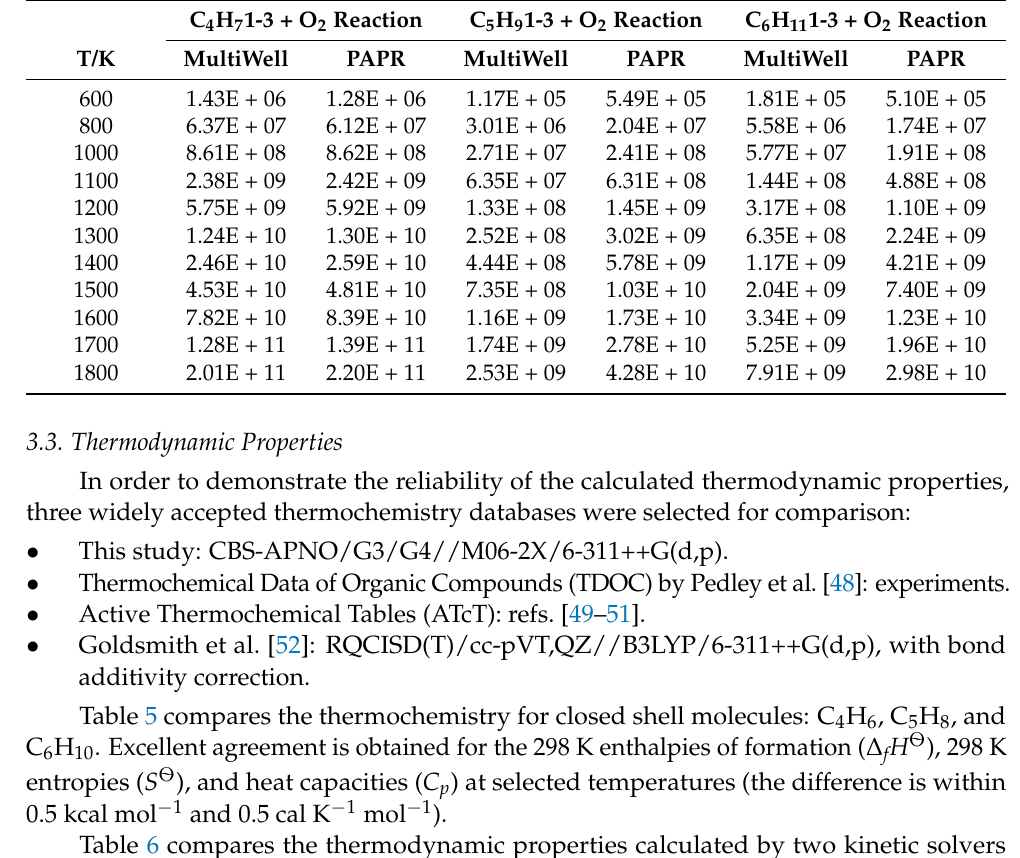
Figure 5. Rate constant comparison for two ab initio solvers: Orca and Gaussian.